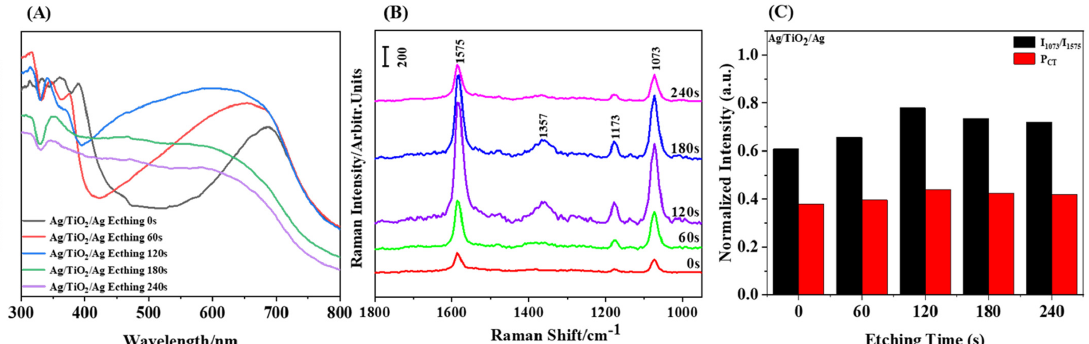
Figure 3. The absorption spectra and SERS spectra of structural change sequences after the intro–duction of TiO 2 . ( A ) The absorption spectra of Ag/Ag nano structural change sequences. ( B ) Ag/TiO 2 /Ag etching 0 s, 60 s, 120 s, 180 s, and 240 s. ( C ) Relative peak intensity and charge transfer for I 1073 /I 1575 of the Ag/TiO 2 /Ag nanostructure.